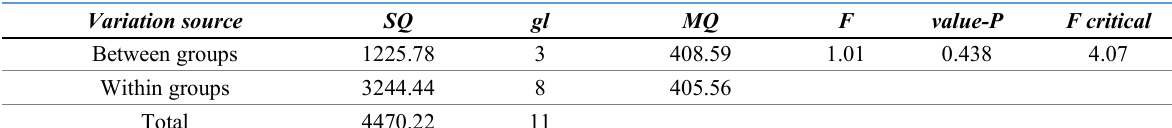
Table 6. ANOVA Phase 2 – the influence of nanosilica